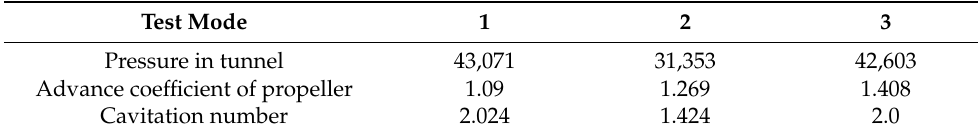
Table 2. The test